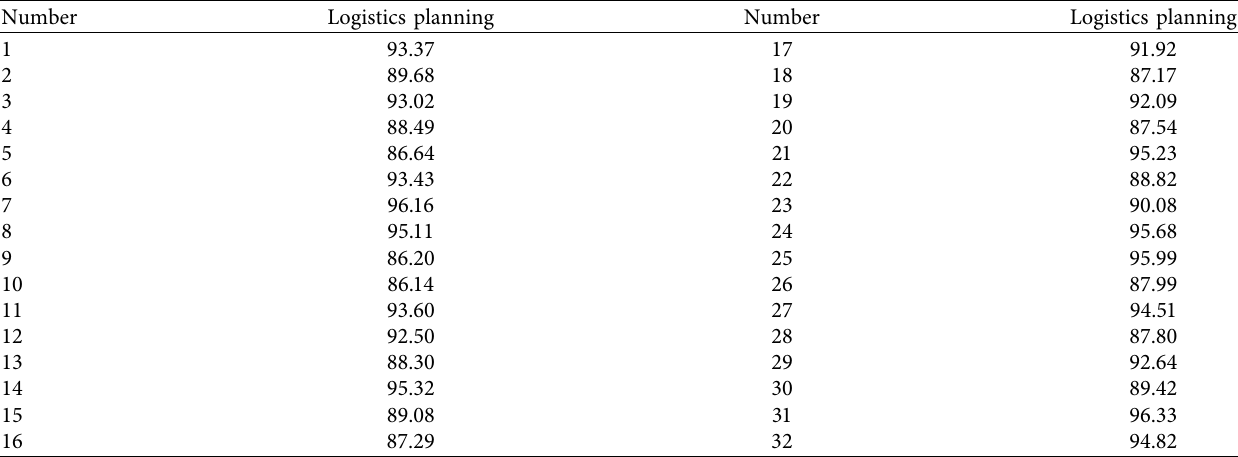
Figure 10: Performance evaluation index system. Table 1: Evaluation of logistics planning performance.